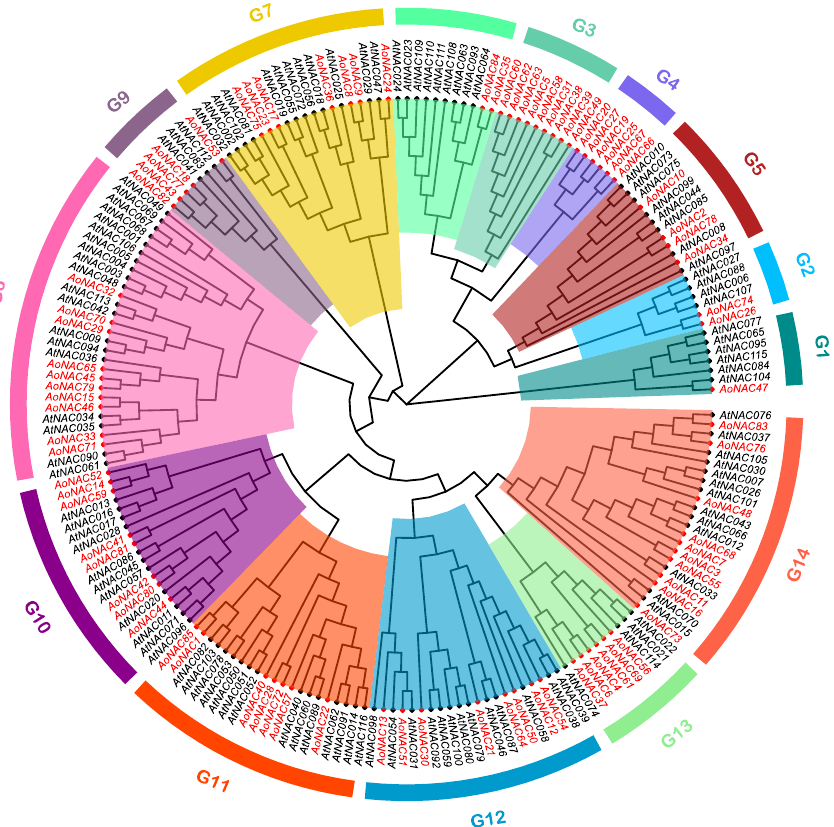
Figure 1. Phylogenetic tree of NAC genes between A. officinalis and A. thaliana . The AoNAC and AtNAC genes are indicated with red and black fonts, respectively. They are divided into 14 subgroups according to the subgroups of Arabidopsis and represented by different colors. The phylogenetic tree was compiled by the Maximum Likelihood (ML) method, with 1000 bootstrap replicates.